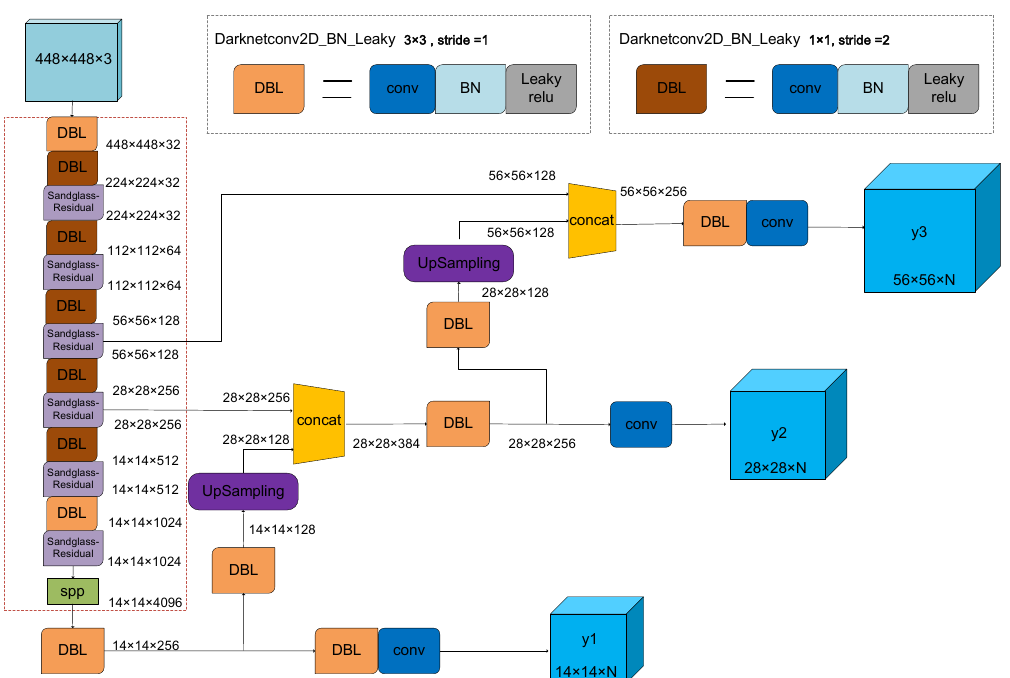
Figure 5. SAS-YOLOv3-tiny network structure.